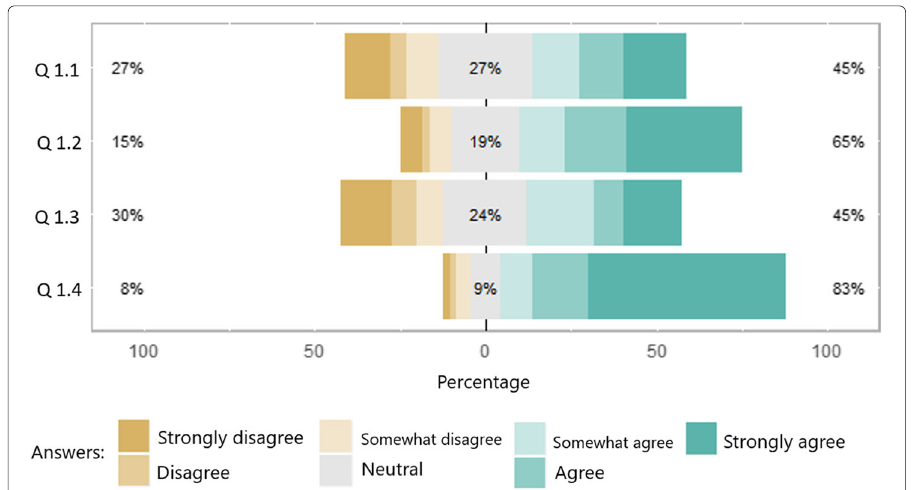
Fig. 5 Perception of utility. Answers to the question about perception of utility when using the tool (source: (Ferreira et al.